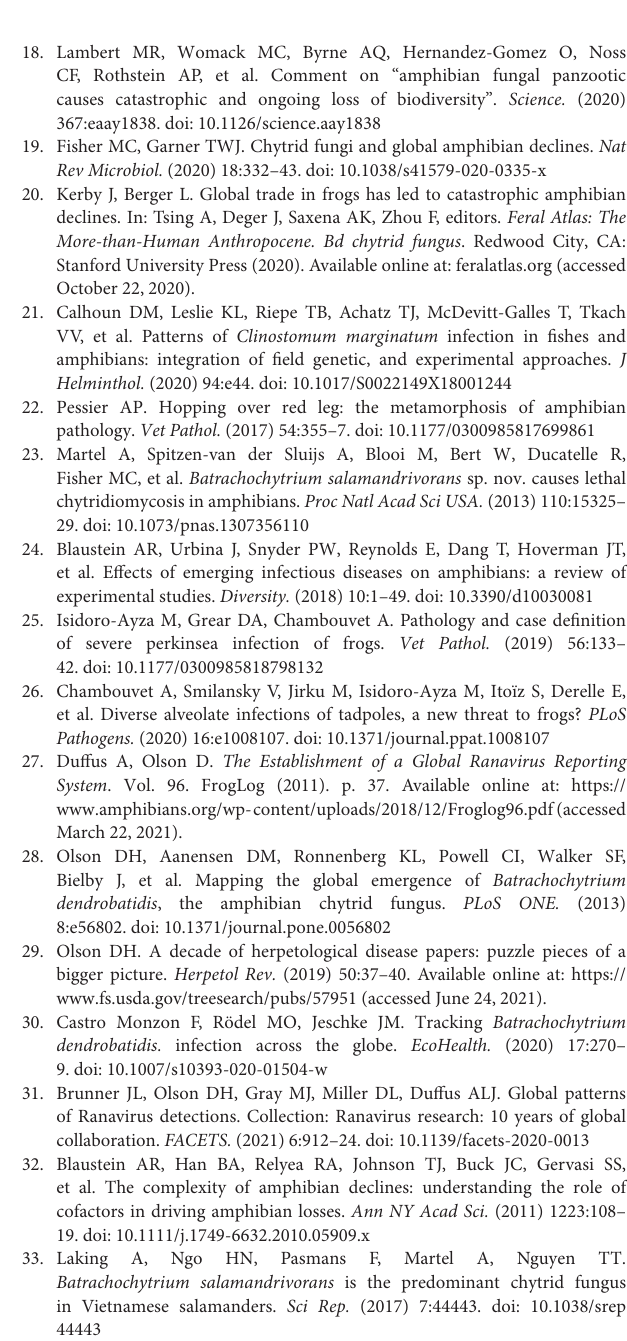
Supplementary Table 3 | Batrachochytrium dendrobatidis ( Bd ) detections by country, with source citations (see Data References following Supplementary Table 2